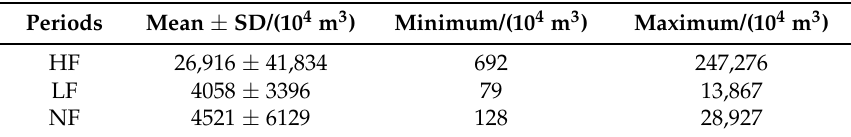
Note: SD is the abbreviation of standard deviation.